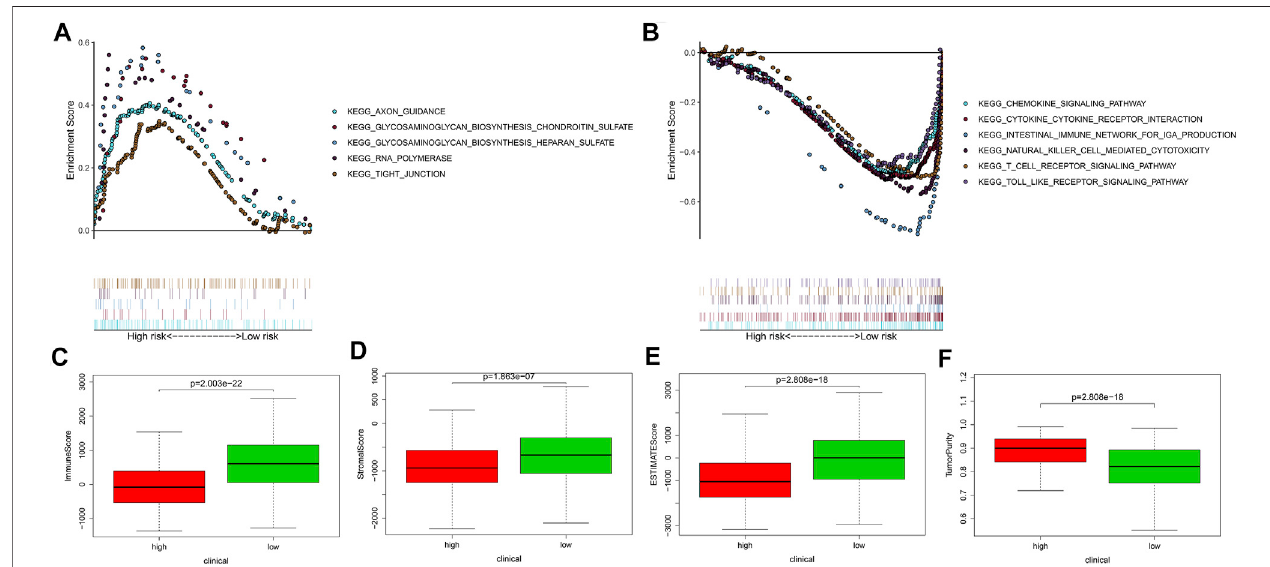
FIGURE 5 | The gene set enrichment analysis, the immune, stromal, and ESTIMATE scores, and the tumor purity of different risk groups. (A,B) The gene set enrichmentanalysisshowedthesigni fi cantlyenrichedKyotoEncyclopediaofGenesandGenomes(KEGG)pathwaysinTCGA. (C – F) TheAVONAresultsoftheimmune, stromal, and ESTIMATE scores and tumor purity in the high- and low-risk groups. Patients in the high-risk group had lower immune score, stromal score, ESTIMATE score, and higher tumor purity. In the high-risk group, N (cid:1) 267; in the low-risk group, N (cid:1) 244.